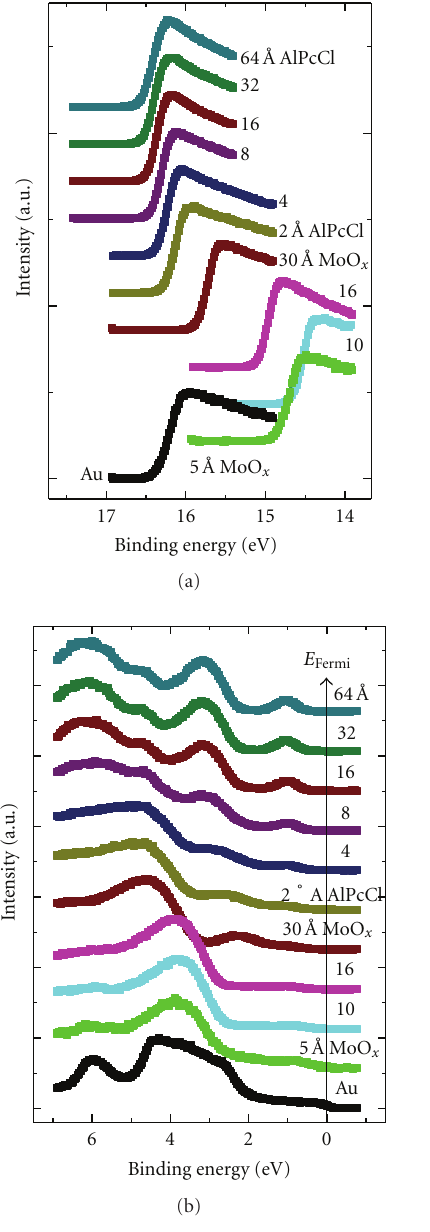
Figure 3: UPS data for Au, 5 ˚A MoO 2 , 10 ˚A, 16 ˚A, 30 ˚A MoO 2 , 2 ˚A AlPc-Cl, 4 ˚A, 8 ˚A, 16 ˚A, 32 ˚A, and 64 ˚A AlPc-Cl. (a) The cut-o ff region and (b) the HOMO